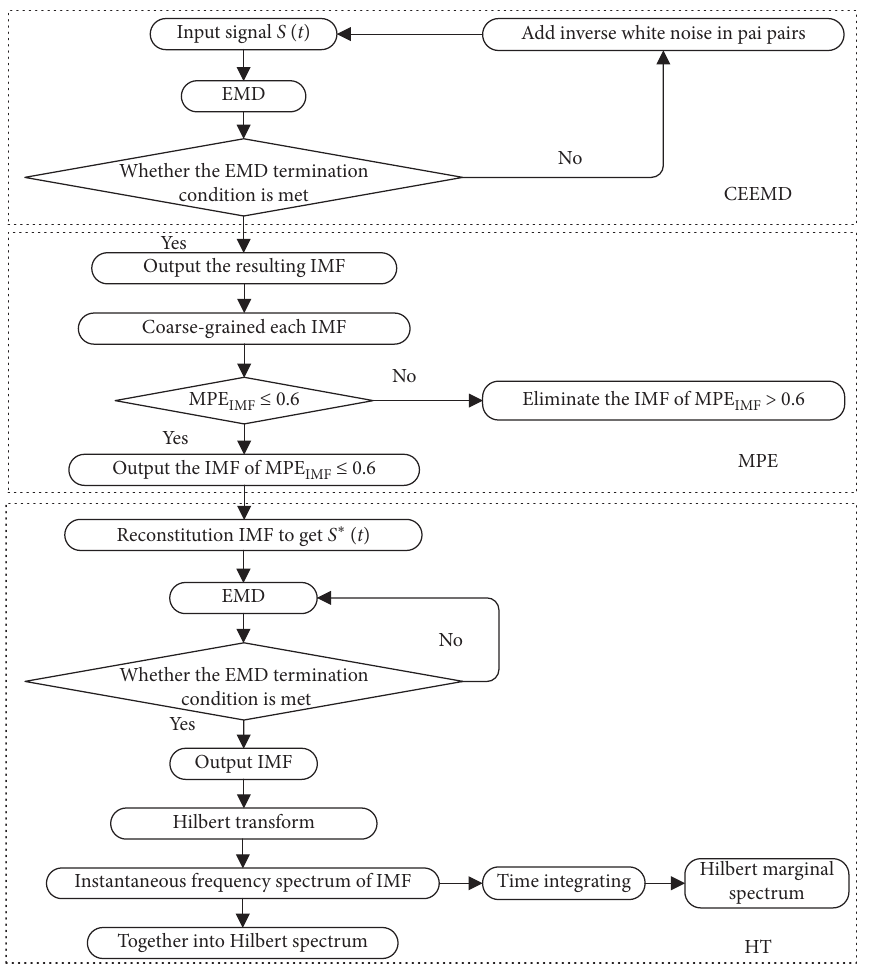
Figure 1: Flow chart of the CEEMD-MPE-HT time-frequency analysis